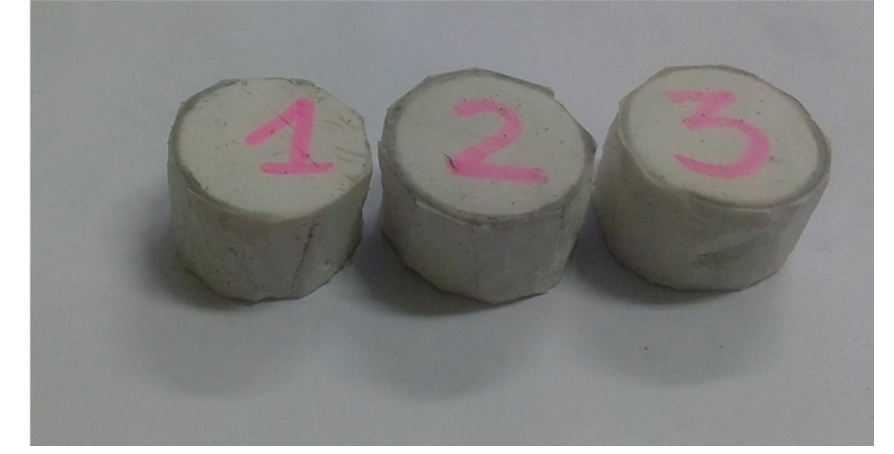
Figure 4. The three test